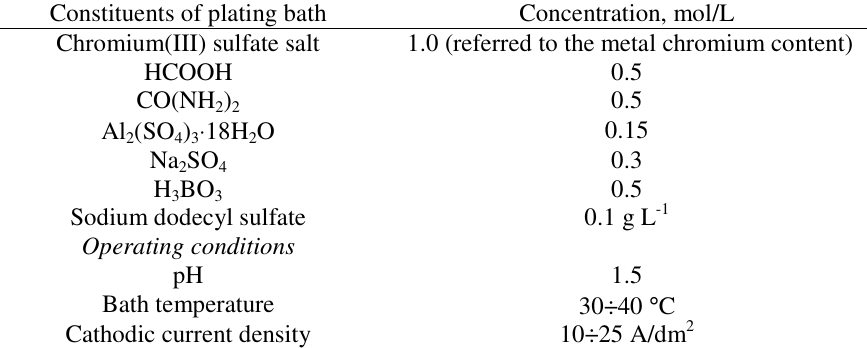
Table 1. Basic trivalent chromium bath composition and operating